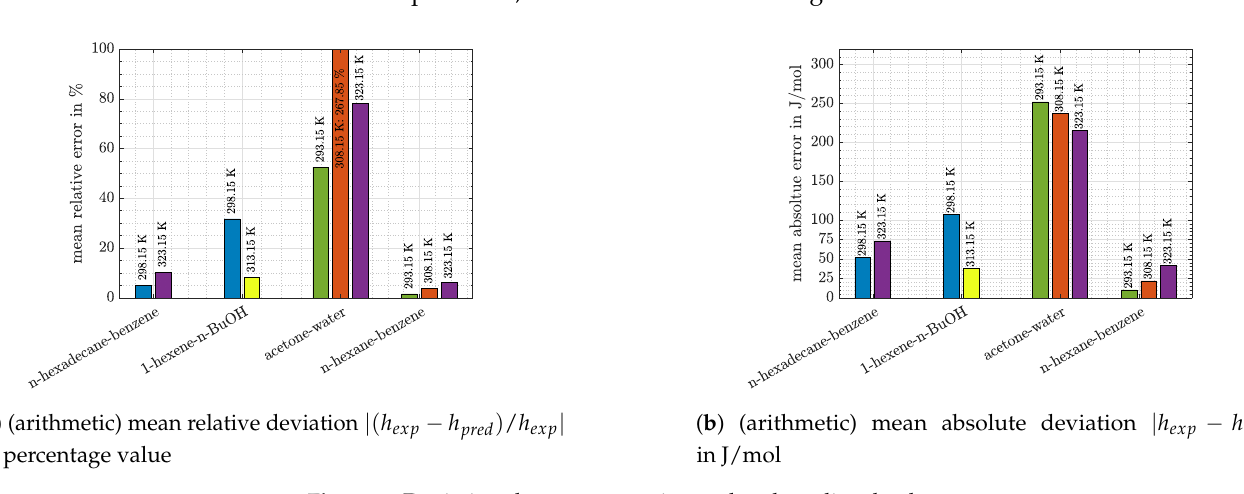
Figure 5. Deviations between experimental and predicted